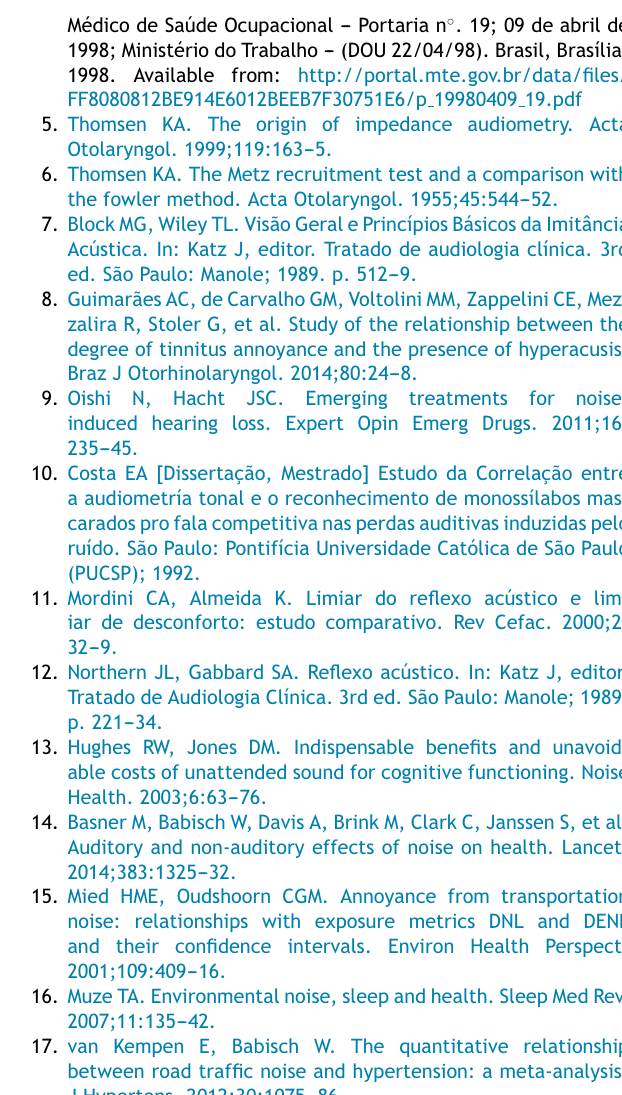
and their confidence intervals. Environ Health Perspect.